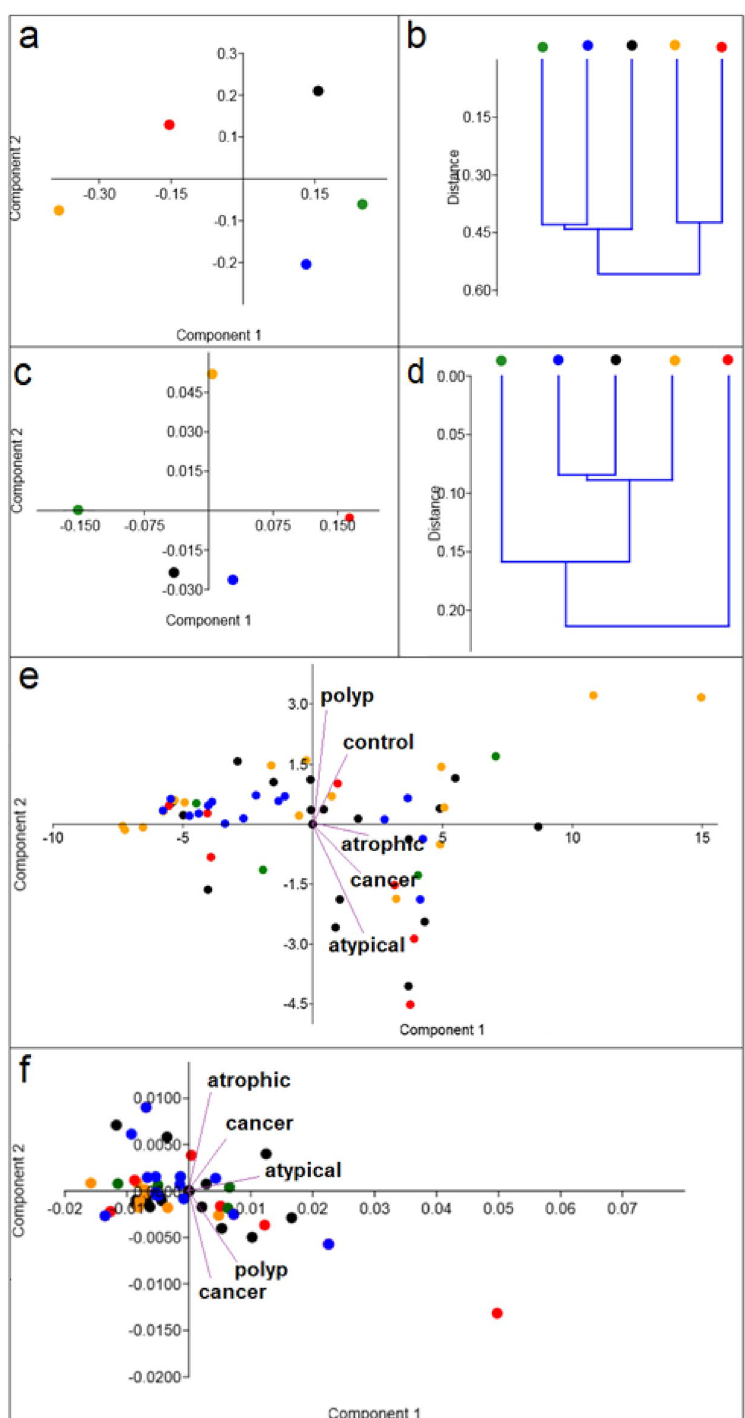
Figure 4. PCA ( a , c , e , f ) and HCA ( b , d ) analysis of: control (black dot); atrophic endometrium (orange dot); complex atypical hyperplasia (red dot); endometrial polyp (green dot); endometrioid adenocarcinoma (blue dot) Raman ( a , b , e ) and FTIR ( c , d , f ) spectra. Two-dimensional (2D) scores plot of samples with differences in chemical compositions presented through the selected spectral regions: all spectral region for Raman spectra and points corresponding to C–O stretching mode of C–OH groups of serine, threonine, and tyrosine of protein and νC–O vibration from carbohydrates for FTIR data. The results for average spectra were shown in Figure ( a – d ) and for all analyzed samples— e , f with marker with vectors of least-squared lines representing the various